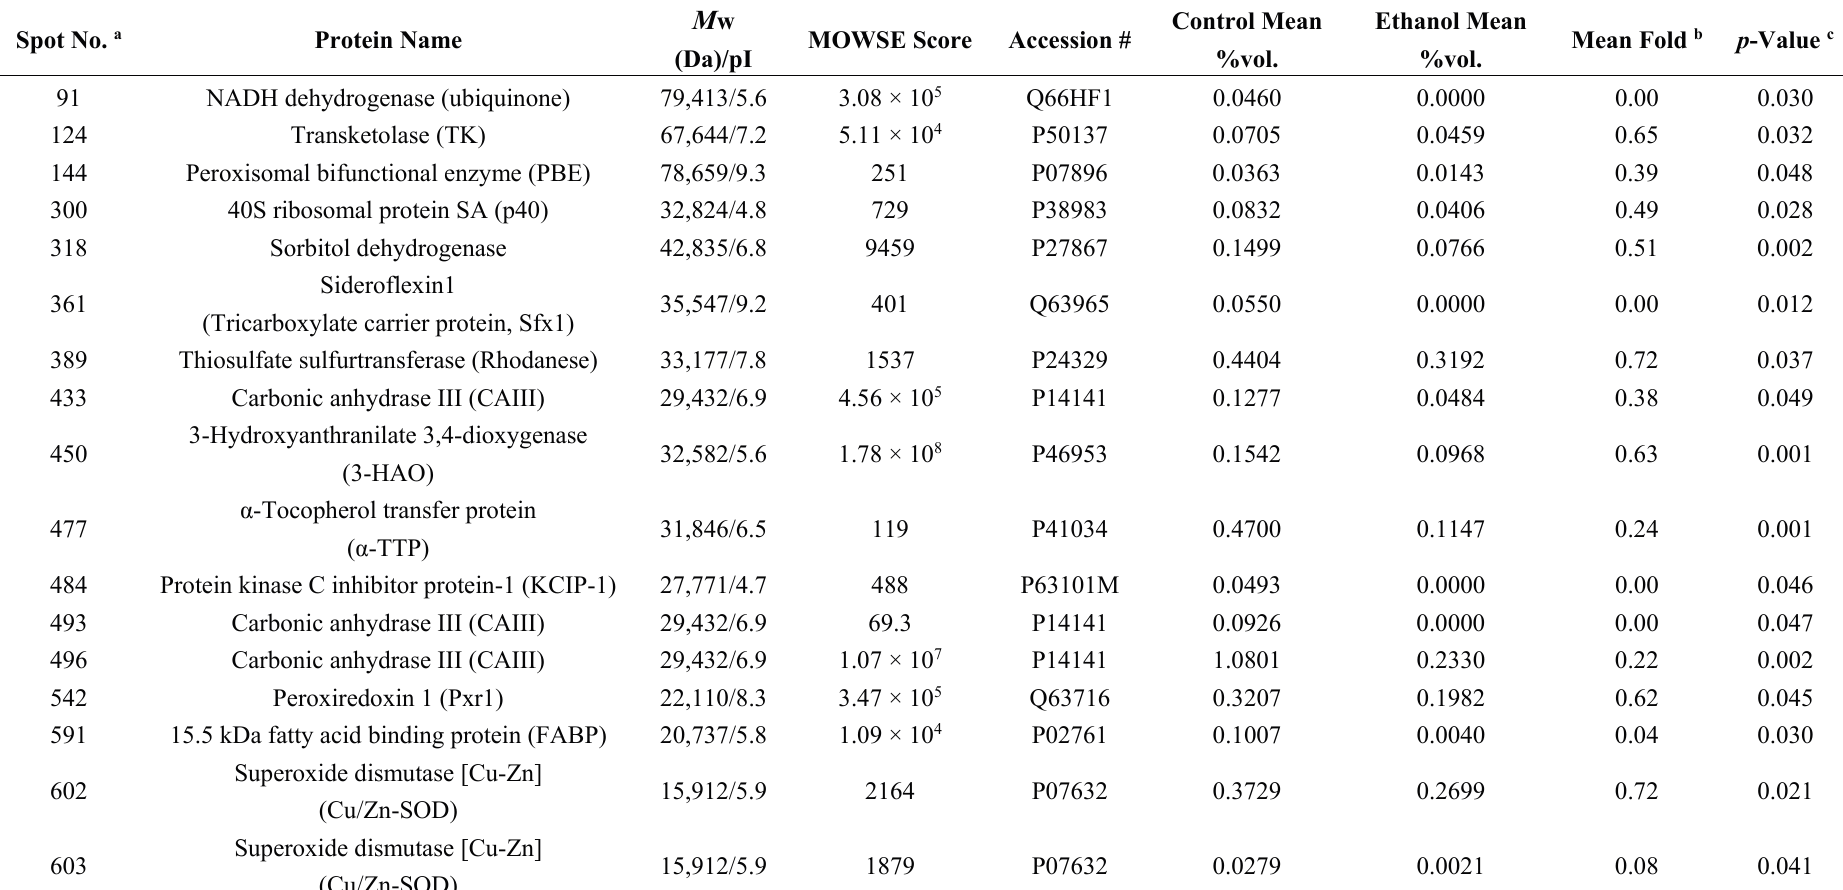
Table 3. Down-regulated proteins in liver cytoplasmic fractions following chronic ethanol consumption: identification of proteins from 2D IEF/SDS-PAGE